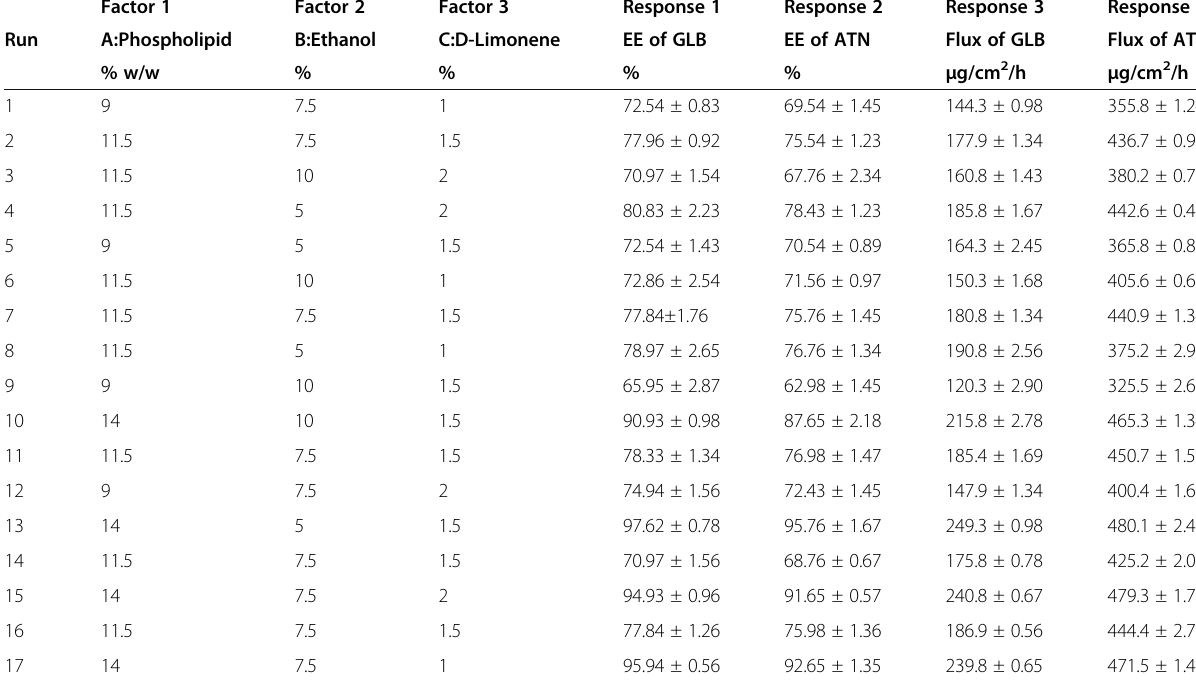
Table 2 Observed responses in Box – Behnken design for development and optimization of NI formulations Factor